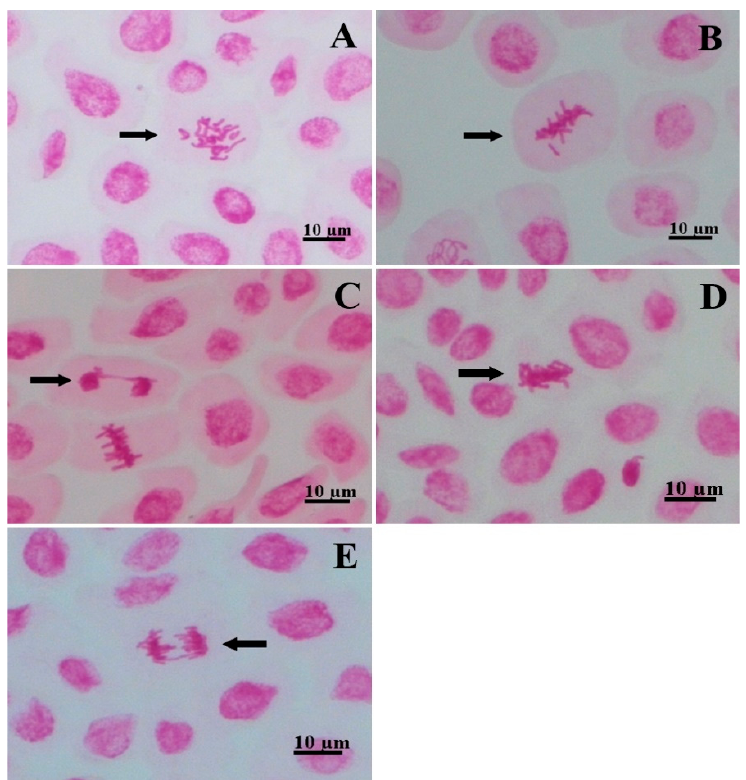
Figure 4. Chromosomal abnormalities identified in the root tips of Lactuca sativa : ( A ) C-metaphase; ( B ) lost chromosome; ( C ) telophase bridge; ( D ) stickiness; ( E ) anaphase bridge. Bar: 10 µm.